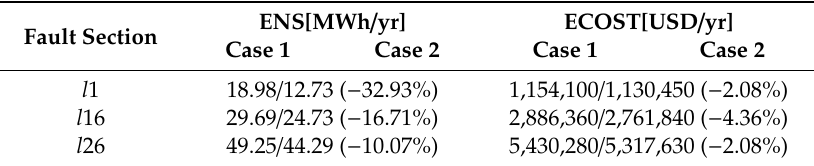
Table 3. Reliability results for the evaluated